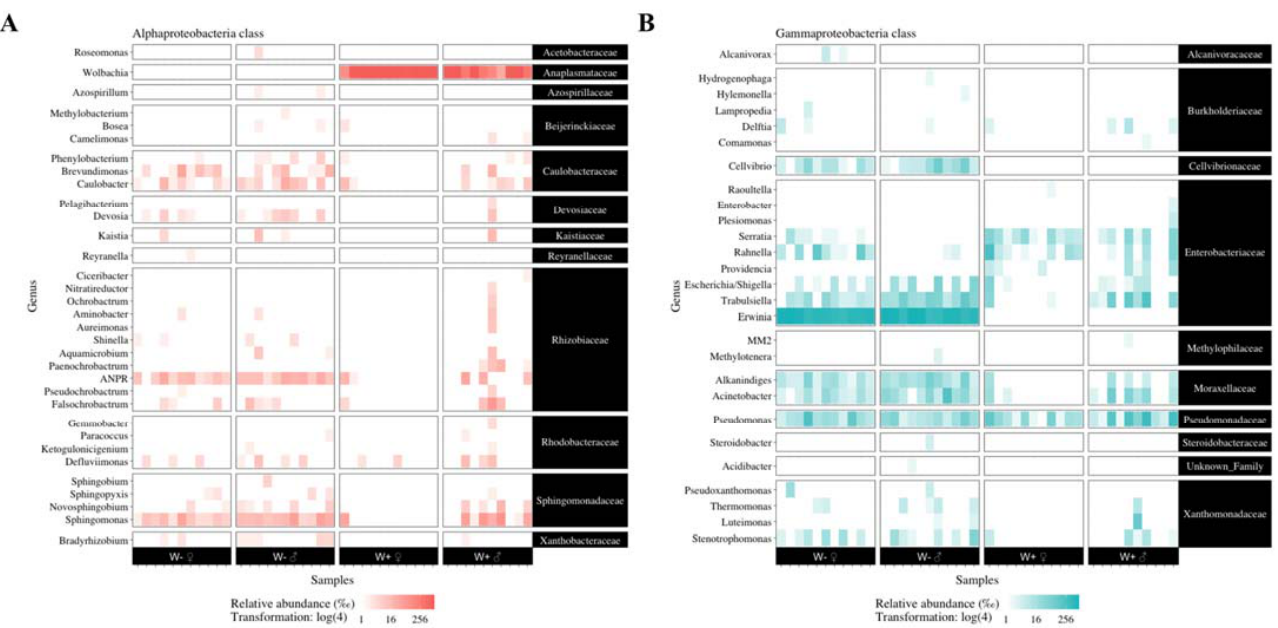
Figure 2. Bacterial community structure of the Wolbachia -free (“W − ” in green) and infected (“W+” in red) lines.